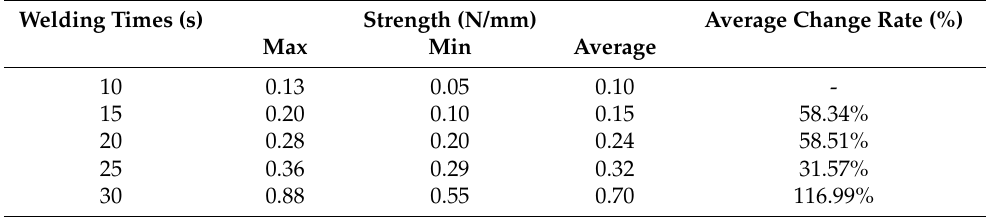
Figure 7. T-peel test results. In order to calculate the average change rate when the welding time is 15 s in Table 3, we added additional welding strength data (welding time is 10 s) in the figure. Scattering points on the left side of the box are specific sample data points. Each group has 10 sample data. However, when the welding time is 30 s, some vessel samples are “burned out”, so there are only four samples. Table 3. T-peel test